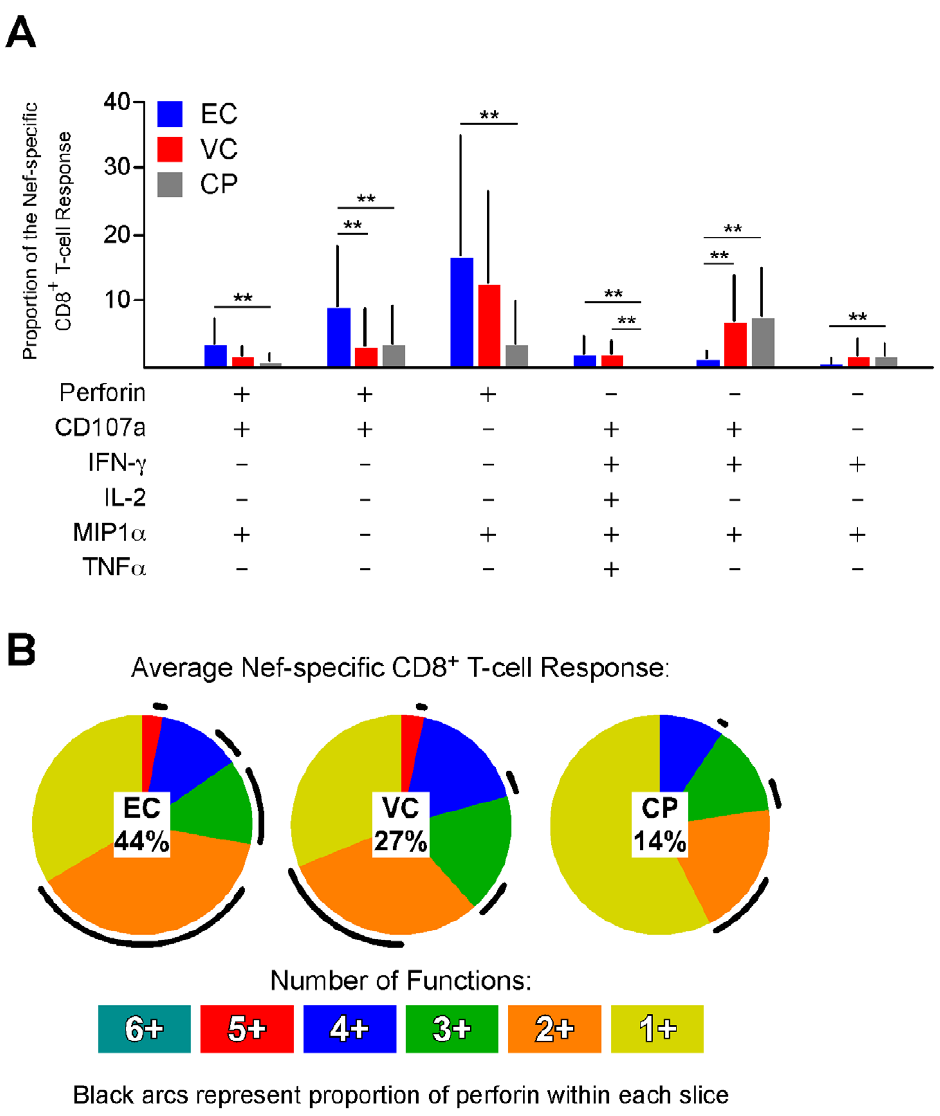
Figure 2. The majority of perforin expression comes from cells with otherwise limited functional capability. (A) The functionality of the average Nef-specific CD8 + T-cell response is shown; only the functional permutations that varied significantly between at least two of the groups are shown. ** denotes a p value , 0.01 based on a Lachenbruch’s Two-part Wilcoxon test as described in the Methods. All bars represent the mean and error bars indicate the standard deviation. (B) The average Nef-specific CD8 + T-cell functional profile is shown for EC, VC, and CP. Responses are grouped according to the number of positive functions. The relative amount of perforin positivity within each functional group (i.e. each pie slice) is depicted as black arcs. The relative contribution of perforin (mean value) to the entire response is represented by the percentage in the center of each pie.